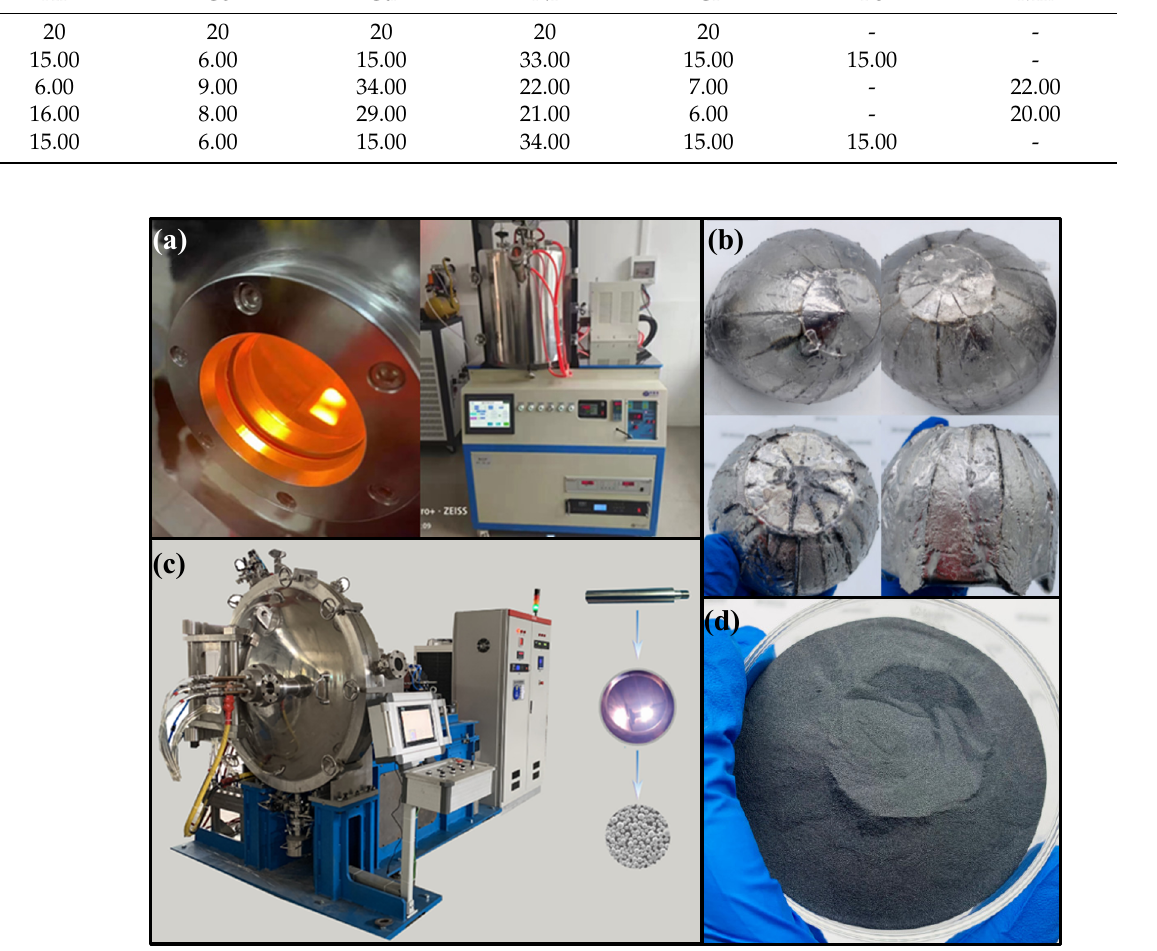
Figure 1. Preparation process diagram of HEAs Powders. ( a ) Vacuum arc melting process diagram, ( b ) Different high entropy alloy ingots, ( c ) The device of gas atomization, ( d ) The HEAs powders. Table 1. Chemical compositions of 5 kinds of high entropy alloy ingots produced by vacuum arc melting. (at. %).